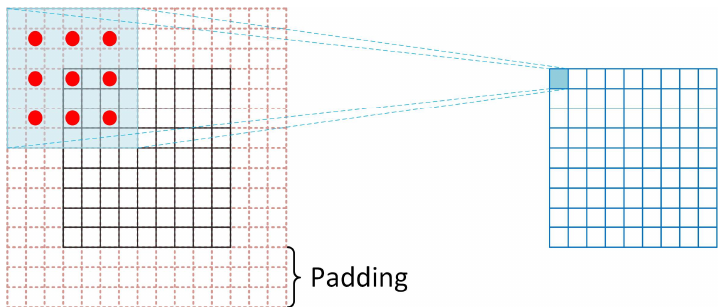
Figure 6. An illustration of dilated convolution. The input feature map is of size 9 × 9 and padded with 3 pixels. The padding value is zero. The convolution kernel is of size 3 × 3 and its dilation rate equals 2. Each element in the resulting feature map has a receptive field of 7 × 7.